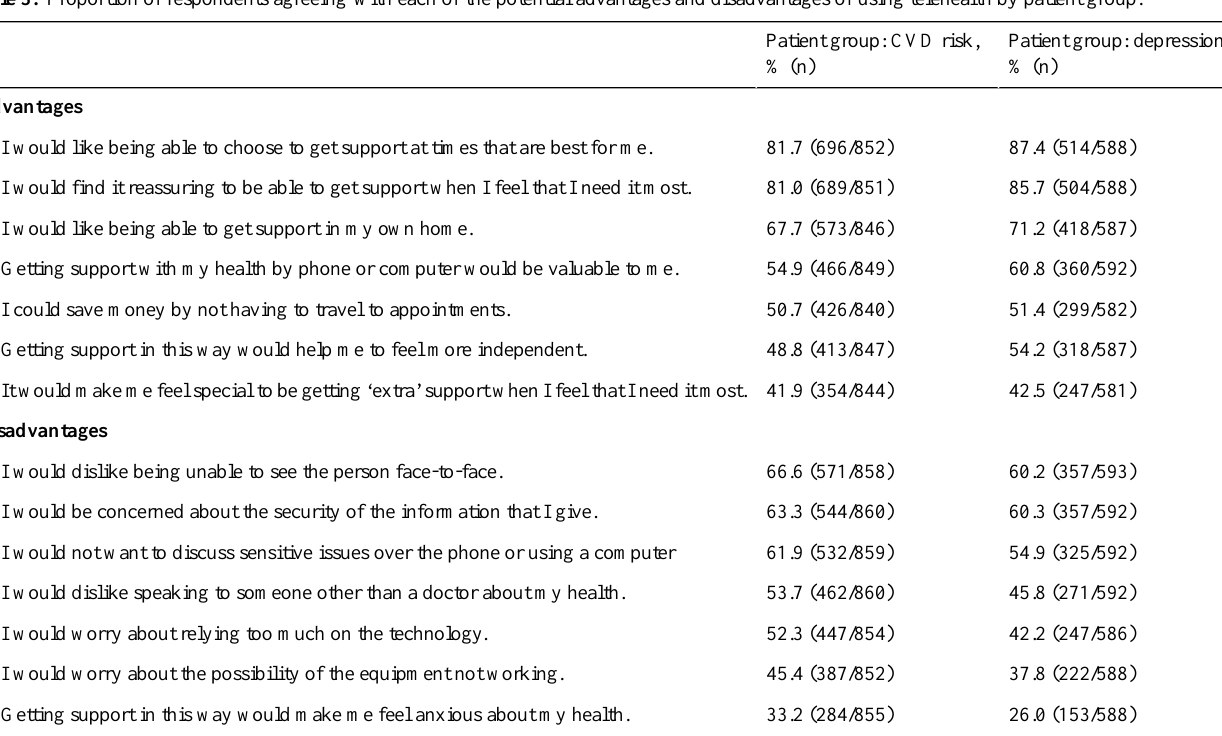
Table 3. Proportion of respondents agreeing a with each of the potential advantages and disadvantages of using telehealth by patient group.